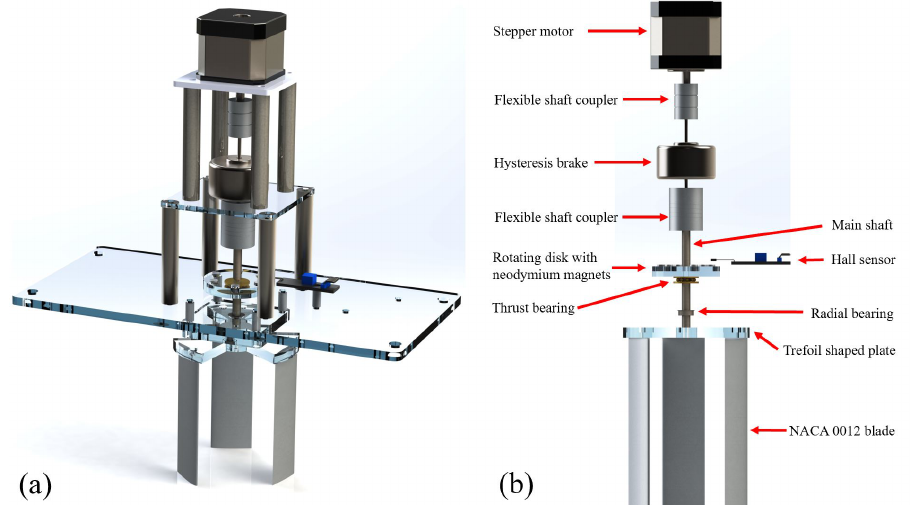
Figure 3. A rendered picture of the turbine apparatus ( a ) and its critical mechanical and electronic components ( b ).